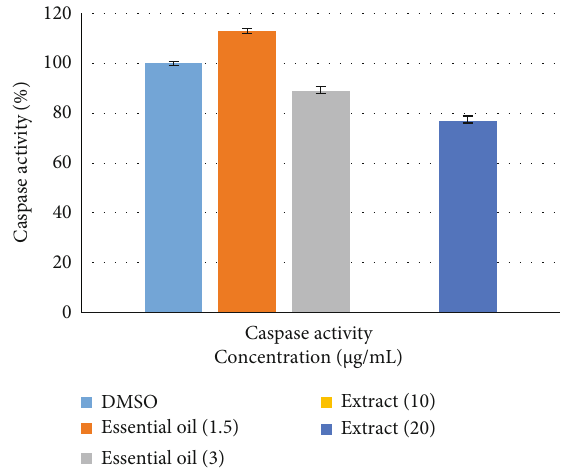
Figure 2: E ff ect of di ff erent concentrations of aqueous extract and essential oil of D. ammoniacum oleo-gum resin on caspase-3 activity in A549 cells. Caspase-3 activity was measured based on the p-nitroaniline colorimetric reaction, and the data were expressed as a percentage. The results are expressed as mean ± SD of three separate experiments ( n = 3 ). Tukey-Kramer test was used to examine the statistical di ff erence ( ∗ p < 0 : 05 and ∗∗∗ p < 0 : 001 ).